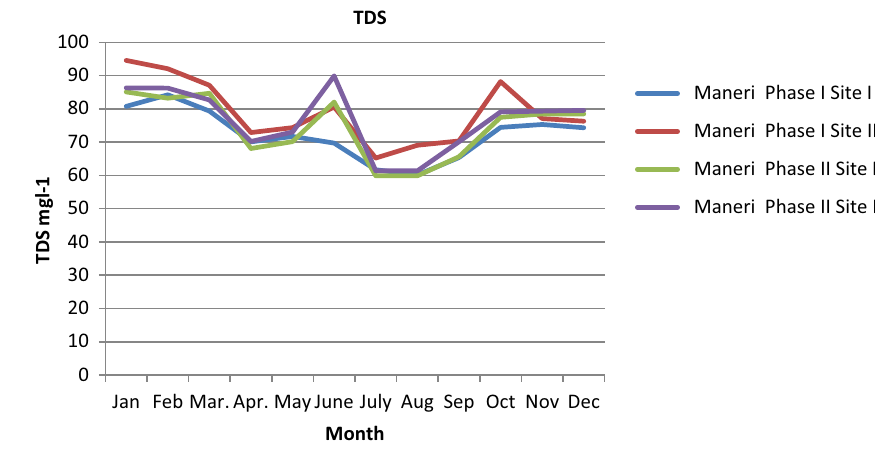
Fig. 10 Monthly recorded TDS